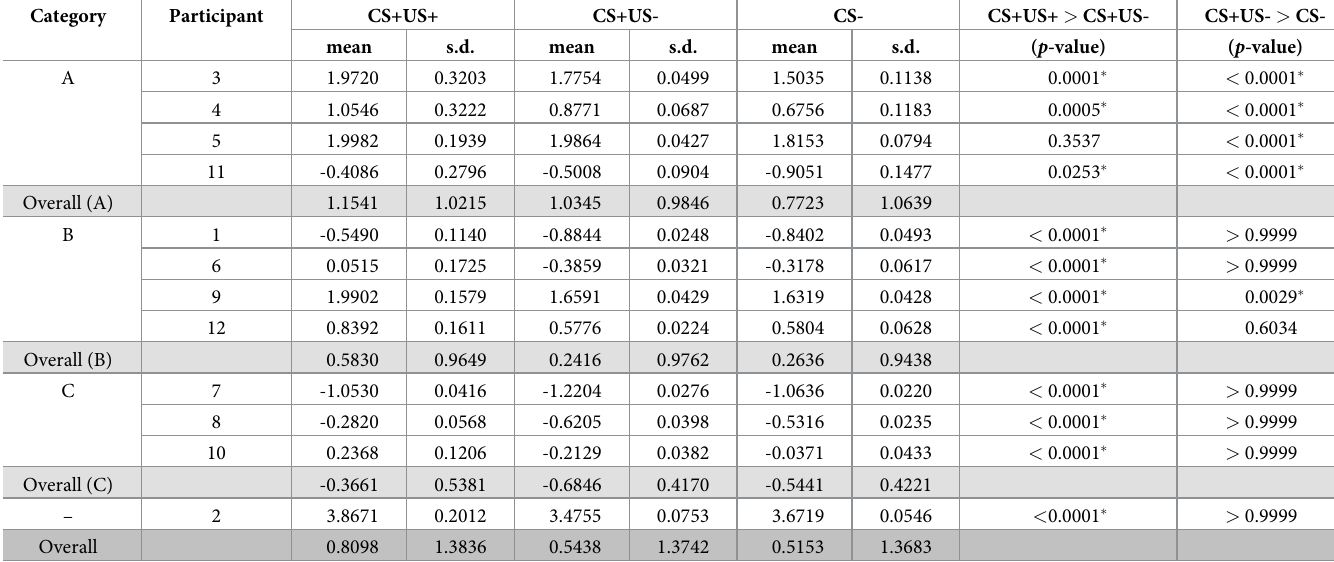
Table 3. Mean and standard deviation of x k in different trial